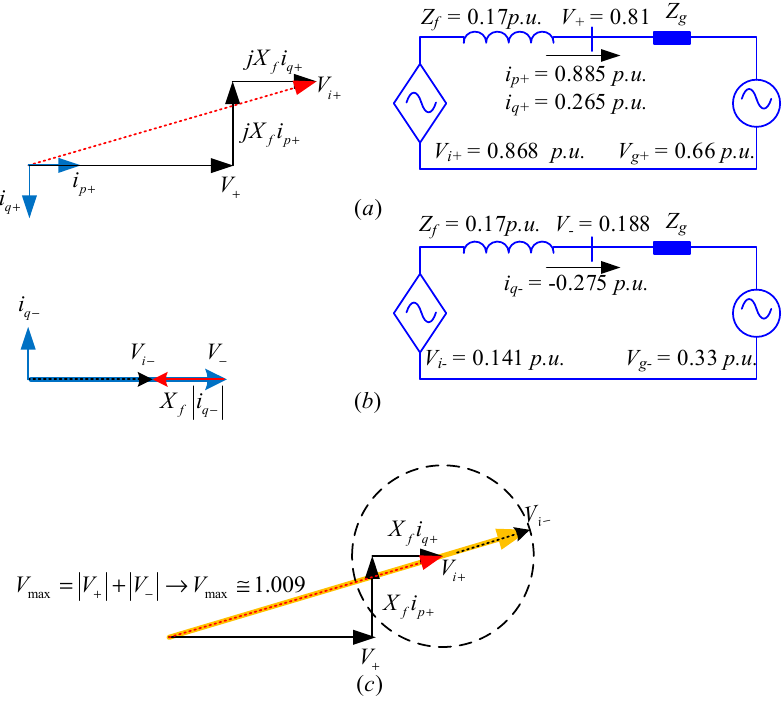
Figure 7. Vector representation of voltages and currents of GC-VSC for unbalanced one phase 100% voltage sag injecting negative sequence current during the fault. ( a ) Positive sequence. ( b ) Negative sequence. ( c ) Inverter voltage in worst case.